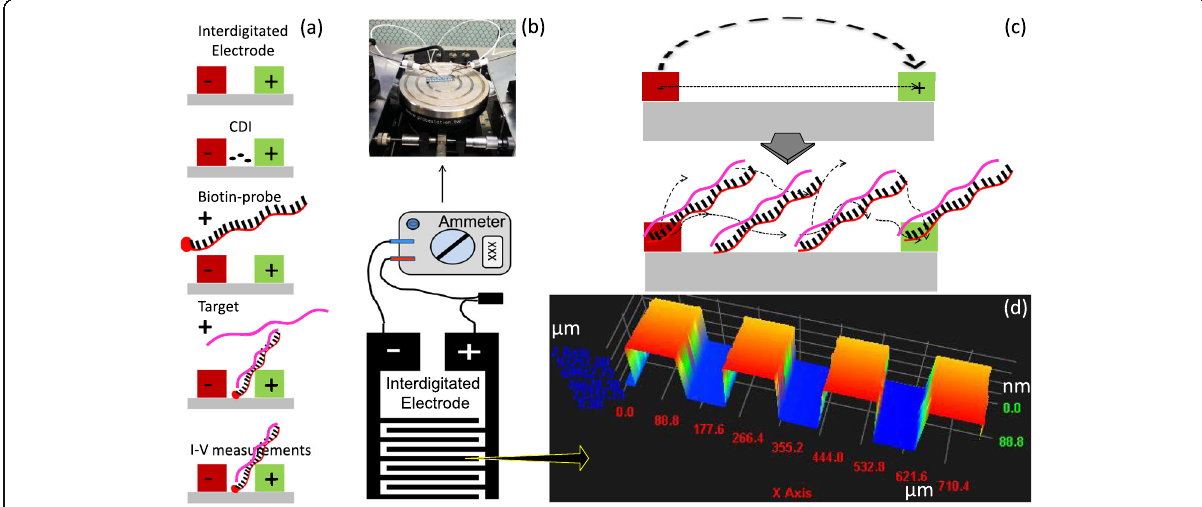
Fig. 2 Surface measurements on an IDE. a Measurement steps. b Measuring mode. The IDE pattern and the connecting system are shown. A dielectric measurement is also displayed. c Surface mechanism during measurement. A dipole moment is shown. d The 3D profilometry profile of the fabricated